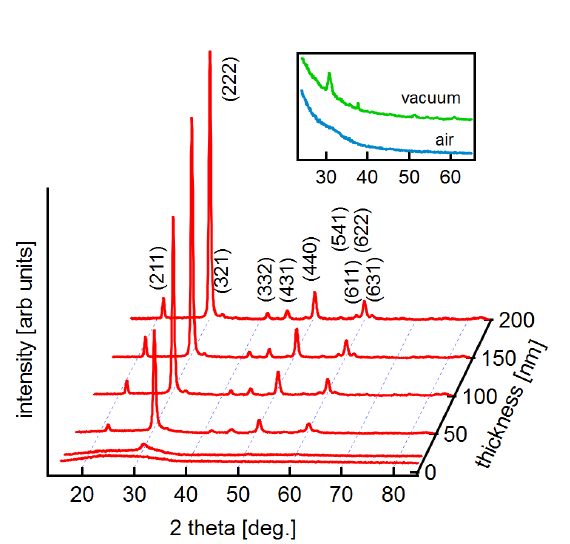
Figure 1. Grazing Incidence XRD patterns of ITO films with different film thickness deposited at room temperature. The indexed lattice planes correspond to those of cubic In 2 O 3 (International Centre for Diffraction Data (ICDD) card 00-006-0416-High-bcc). The insert shows grazing incidence diffraction